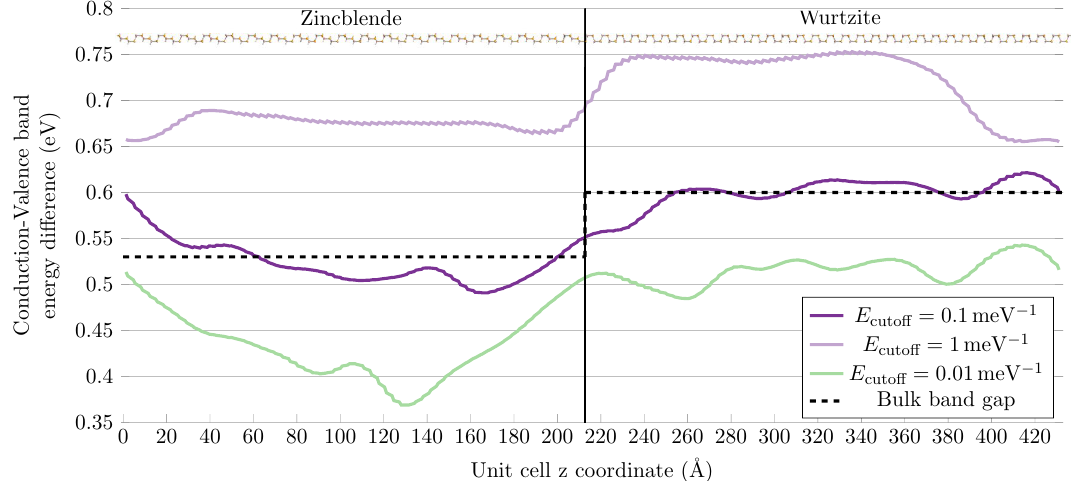
Figure 4. Conduction-valence band energy difference in 127 atomic layer long InP ZB/WZ interface system for three different DOS cutoff